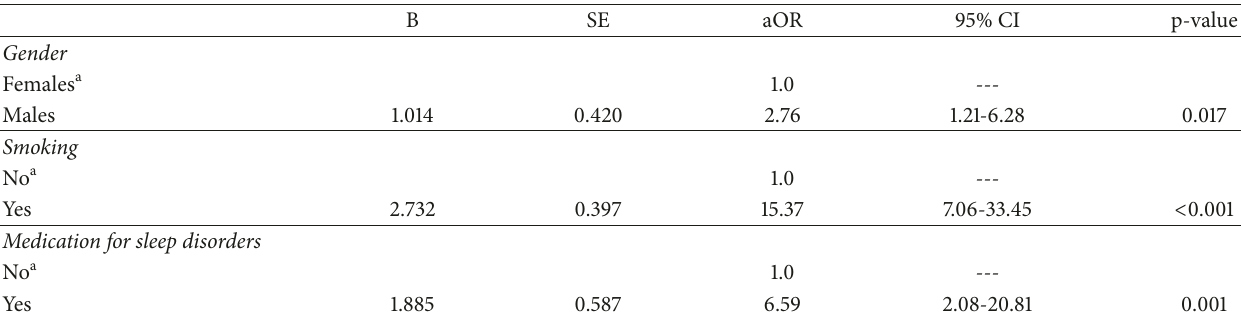
Table 7: Predictors of burnout among emergency department physicians and nurses: multivariate logistic regression analysis. B SE aOR 95% CI